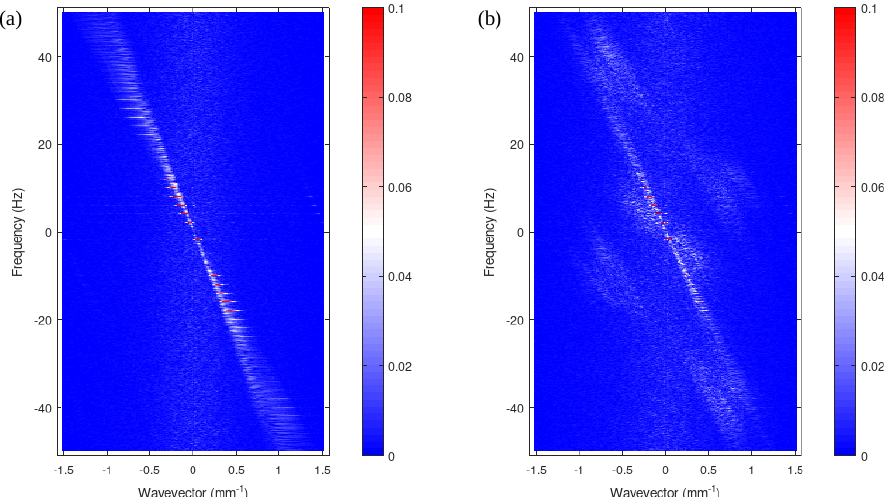
Figure 4. Dispersion maps of the solitary-like waves forced at the frequency of 2Hz. ( a ) No vibration. ( b ) The inclined plate is vibrated with the frequency of 48Hz and the peak vibration amplitude of 1 g. The plots are slightly oversaturated for the sake of a better visual